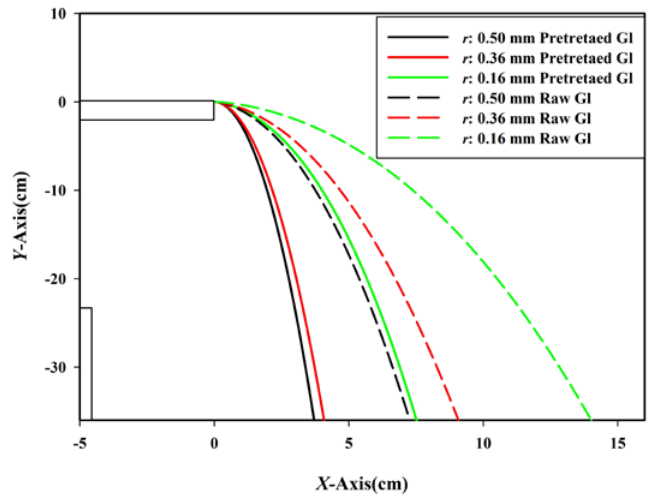
Figure 11. Observed trajectories of raw vs. pretreated glass (applied voltage: 20 kV, relative humidity: 35%, distance between electrodes: 60 cm, initial speed: 0.13 m/s).